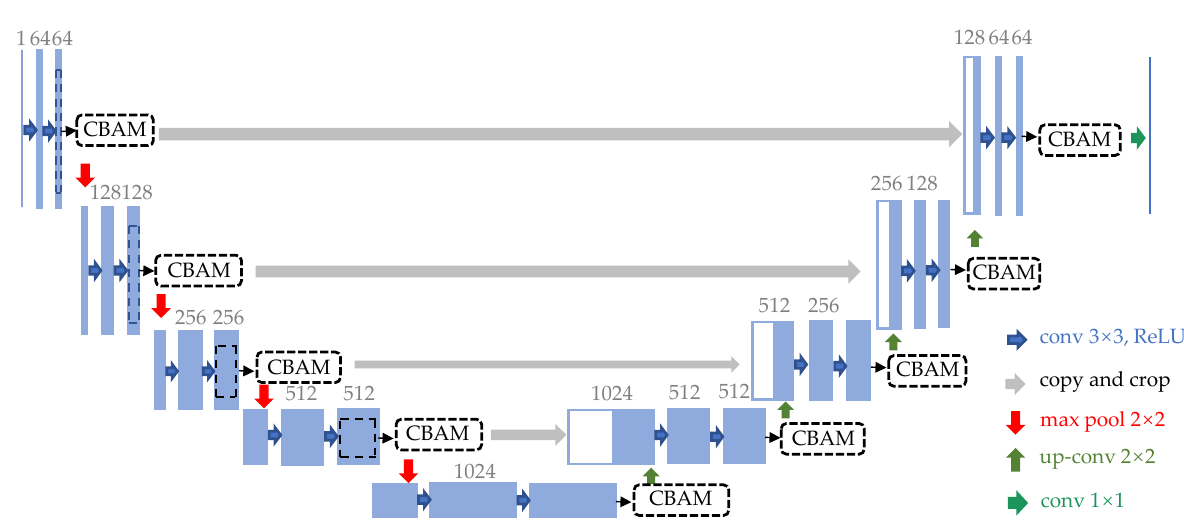
Figure 3. Structural diagram of the U-Net-CBAM network.